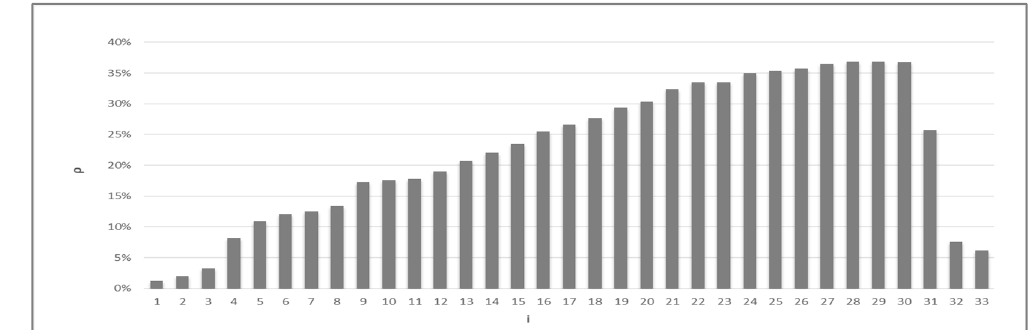
Figure 3. L171: Percentage of vehicle occupancy after each stop.